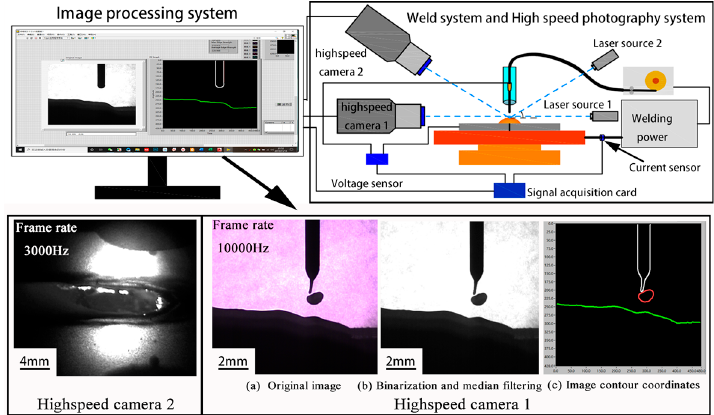
Figure 2. Experiment system and image processing steps: ( a ) original image; ( b ) binarization and median filtering; ( c ) image contour coordinates.